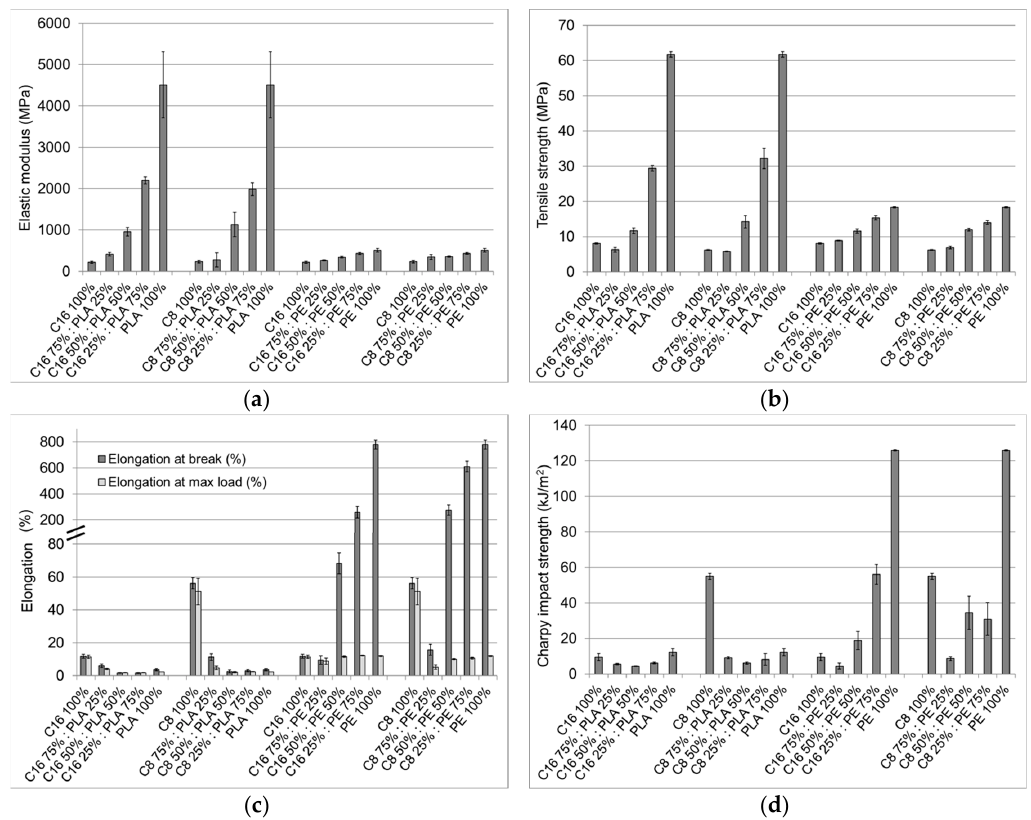
Figure 5. Mechanical properties of injection-molded blends: (a) Elastic modulus; (b) tensile strength; (c) elongation at break; (d) Charpy impact strength.